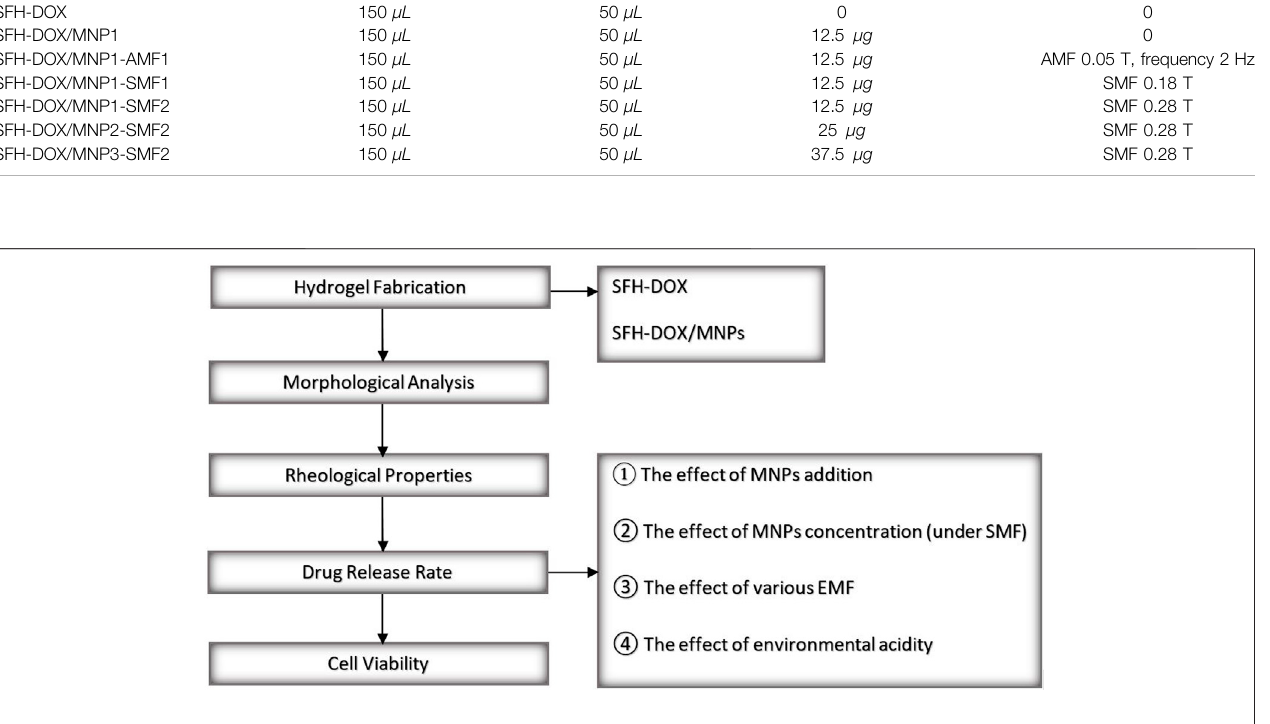
FIGURE 1 | An overview of the present